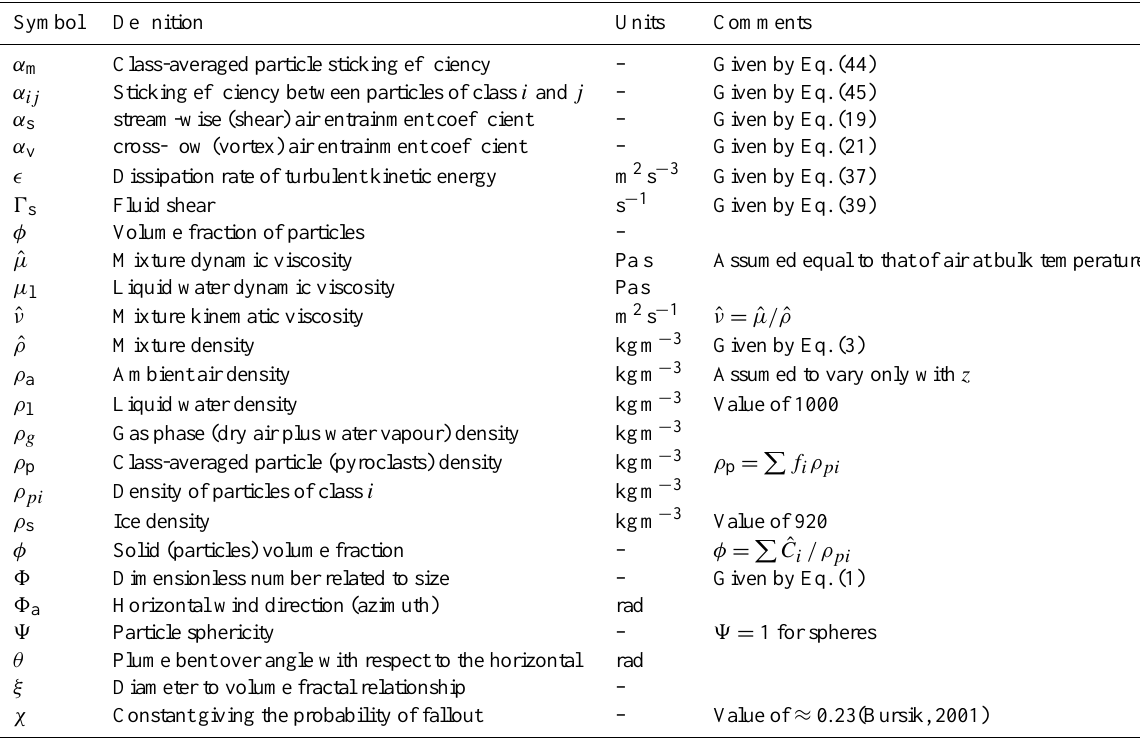
Table 2. List of greek symbols. Quantities with a hat denote bulk (top-hat averaged) quantities. Symbol Definition Units Comments Class-averaged particle sticking